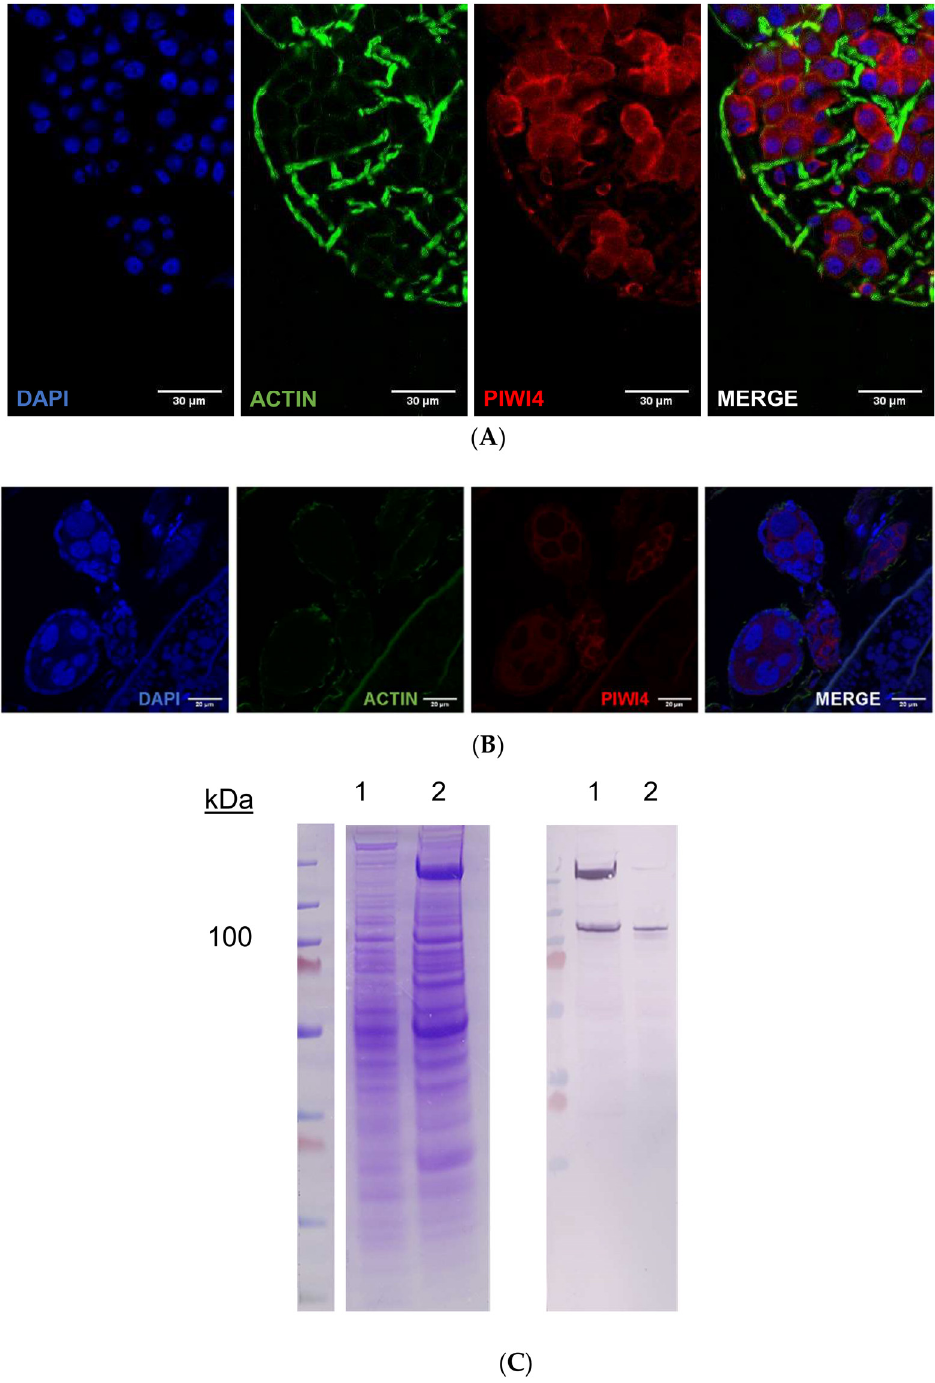
Figure 5. AePiwi4 expression in mosquito tissues. IFA of A. aegypti midgut ( A ) or ovaries with unfertilized embryos ( B ) stained with anti-AePiwi4 (red), phalloidin (green), or DAPI (blue). Scale bars are 30 μ M and 20 μ M for midguts and embryos, respectively; ( C ) Coomassie-stained SDS/PAGE gel (left) and corresponding Western blot of cytoplasmic (lane 1) or nuclear (lane 2) fractions of A. aegypti mosquito ovary tissue.